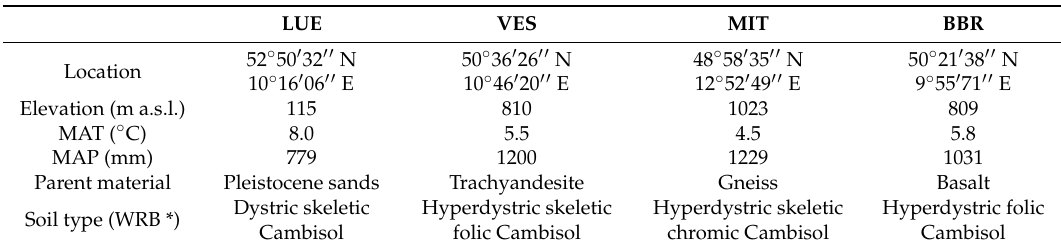
Table 1. Overview over the study